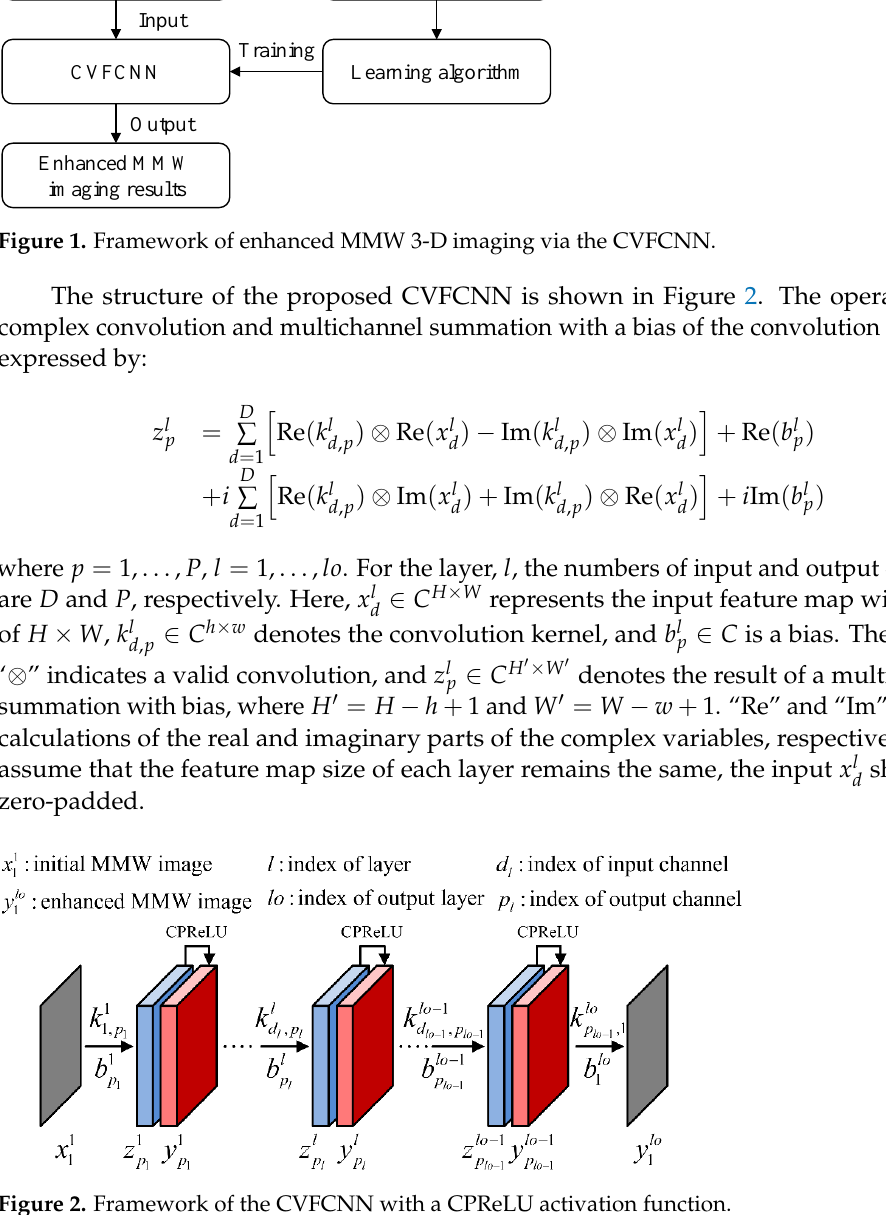
Figure 2. Framework of the CVFCNN with a CPReLU activation function.